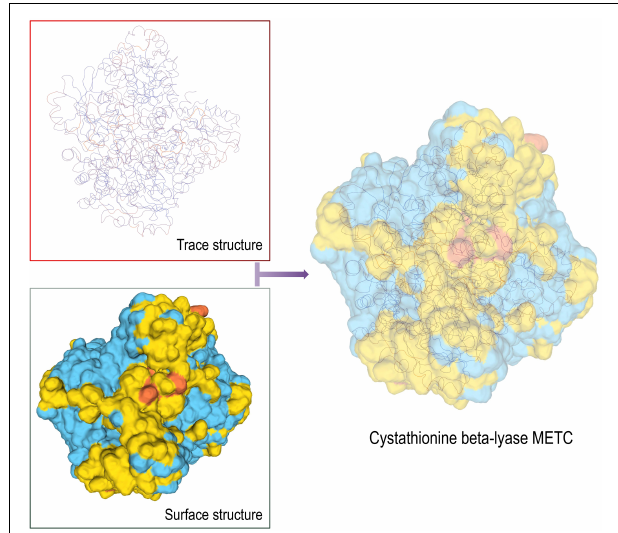
FIGURE 6 | 3D model structure of Cystathionine beta-lyase METC